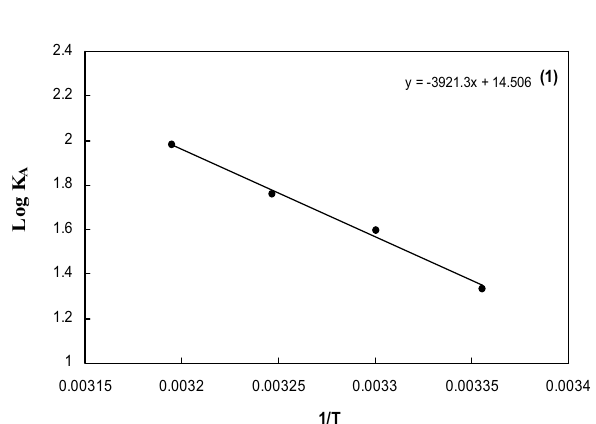
Figure 7. The variation of log K A versus 1/T for Sodium N , N -Dimethyldithiocarbamate in Dimethylformamide at different